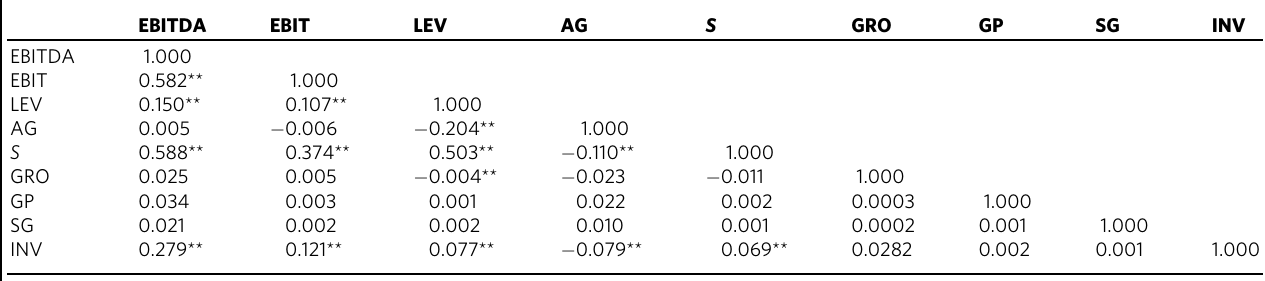
Table 6 Correlation matrix.